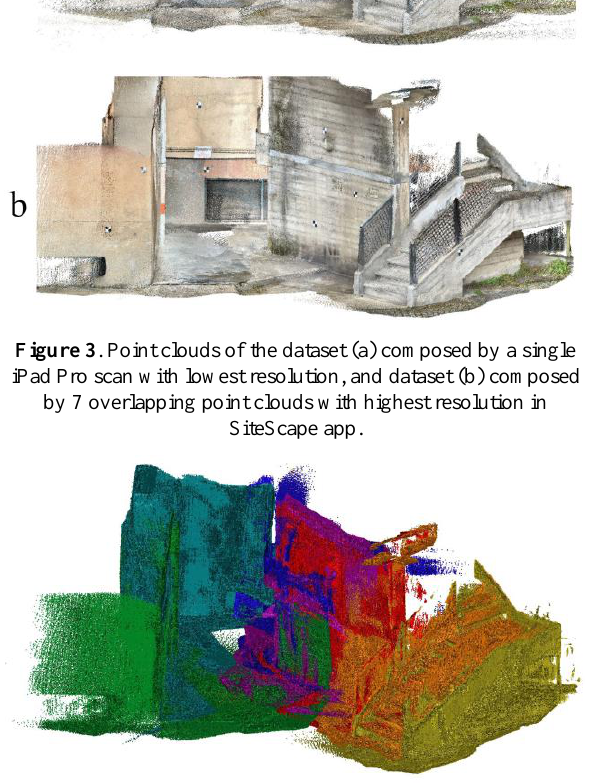
Figure 4 . Dataset (b) composed by 7 overlapping point clouds acquired by IPad Pro with SiteScape app. False colour visualization (each colour represents a different